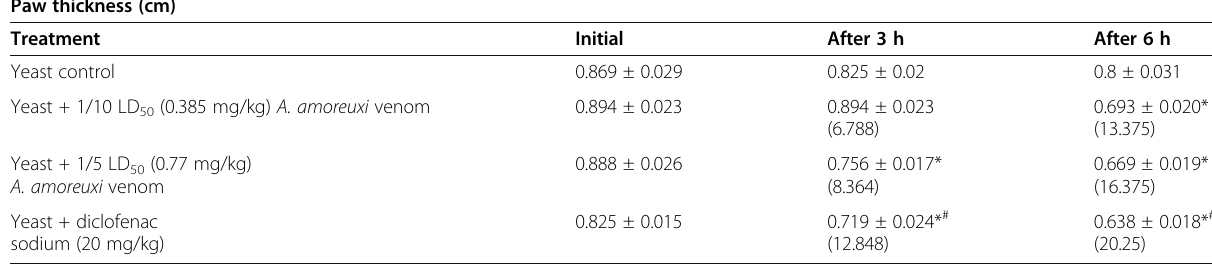
Table 2 Antiinflammatory effect of A. amoreuxi venom using Brewer ’ s yeast-induced paw oedema in rats Paw thickness